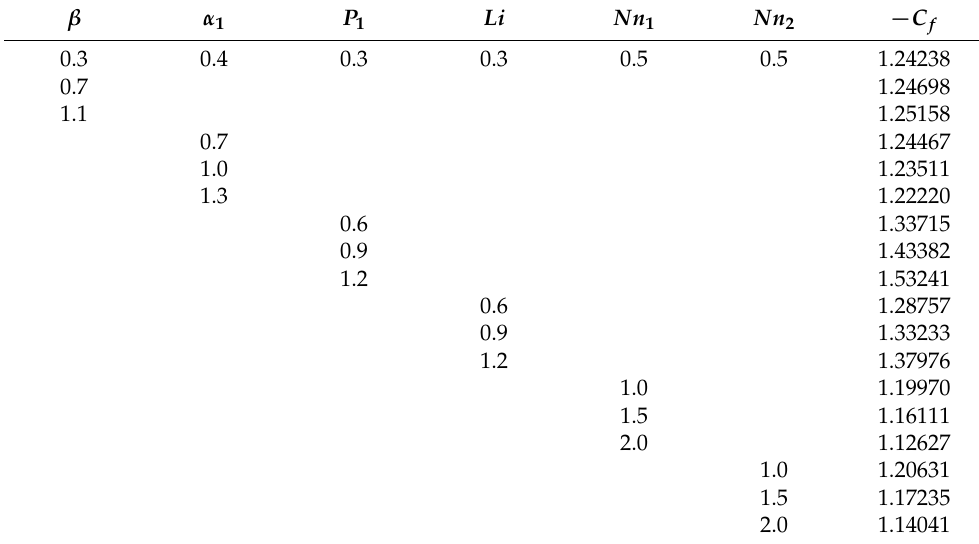
Table 1. Numerical values of skin friction coefficient with varying values of the parameters β , α 1 , P 1 , Li , Nn 1 , Nn 2 .